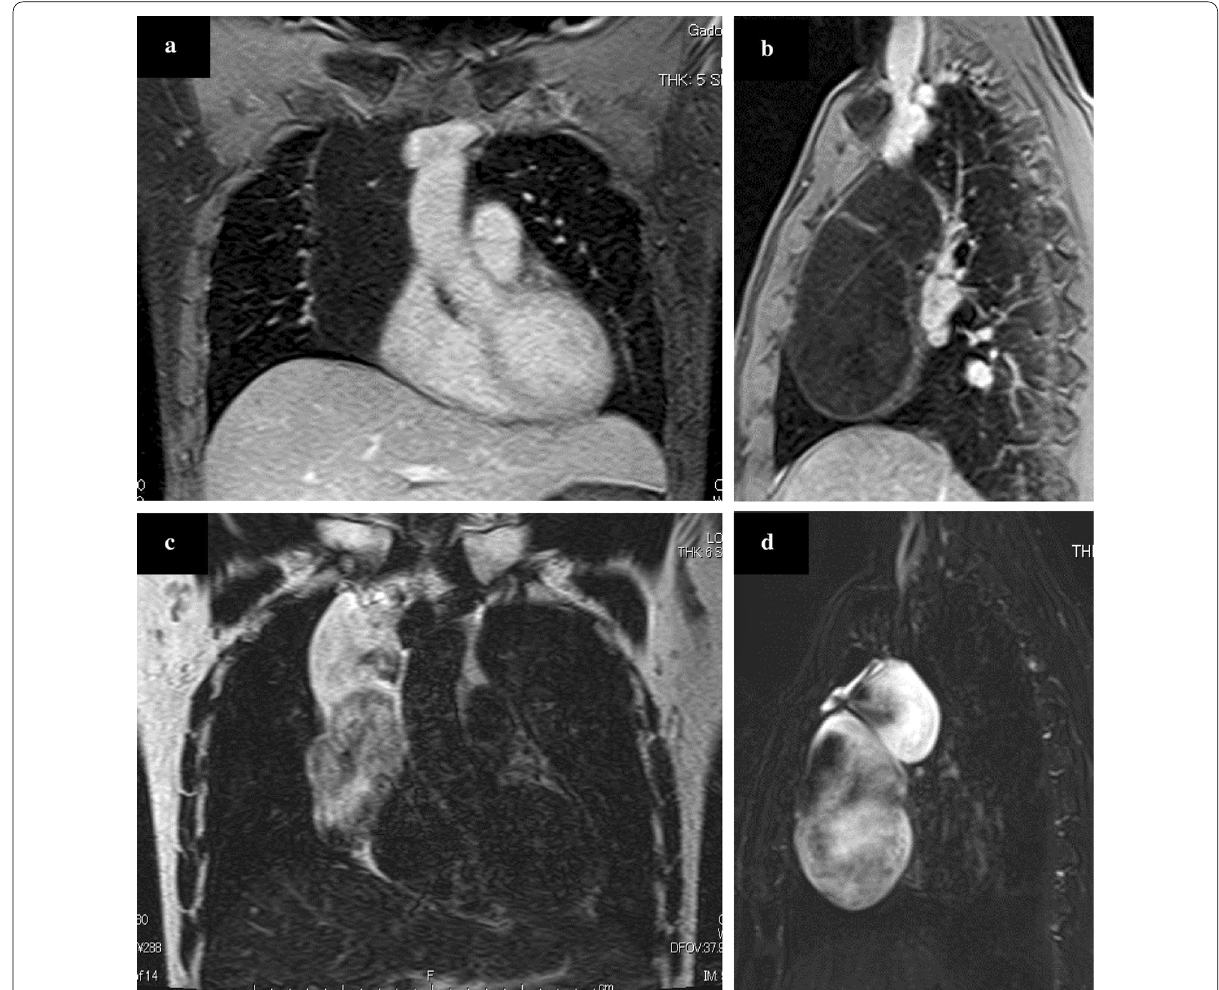
Fig. 3 Chest MRI revealed the contents of a cyst with typical characteristic of fluid, i.e., a , b a low signal intensity on T1-weighted images and c, d high signal intensity on T2-weighted images